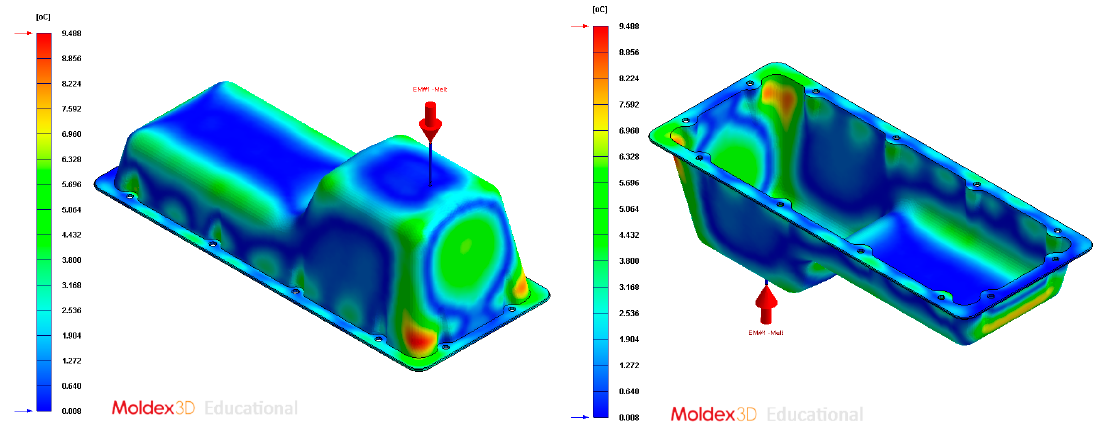
Figure 31. Gradient temperature ( ° C) on the mold surface after the cooling phase, Case C. Front view ( left ) and bottom view ( right ).